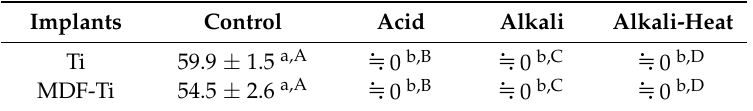
Table 4. Contact angles of surface-treated disks (°).